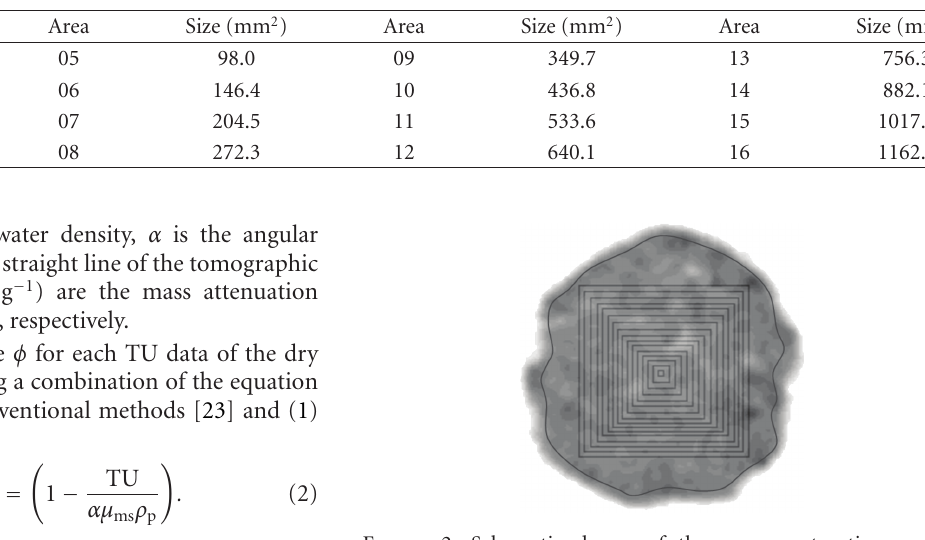
Table 1: Areas (mm 2 ) adopted for the REA definition.